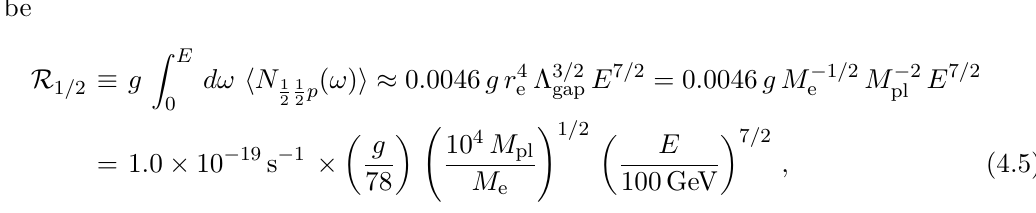
Figure 3 . Time evolutions of charged black holes for two different charges or extremal masses M e = 10 5 M pl and 10 4 M pl . The initial energy is chosen to be 4 × 10 14 GeV. The Hawking radiation is dominated by the Higgs boson and one degree of freedom in W ± and Z gauge bosons. SM fermions, photon and graviton play negligible roles. After t 1 , the black hole starts to decrease energy dramatically and follows a power law E ∝ t − 1 governed by the semiclassical result. After t 2 when E ≈ Λ gap , the quantum effects become important. The evolutions become stochastic with the central values shown in the dashed line ( E ∝ t − 2 / 5 just after t 2 ) and one-sigma variance band shown in the shaded region. After black hole energy drops below the W gauge boson mass M W = 80 . 4 GeV, its evolution is approximately stopped. t univ denotes the age of current universe. relation of E ≈ 3 T/ 2 and the greybody factors. The emission rate to fermions is calculated to